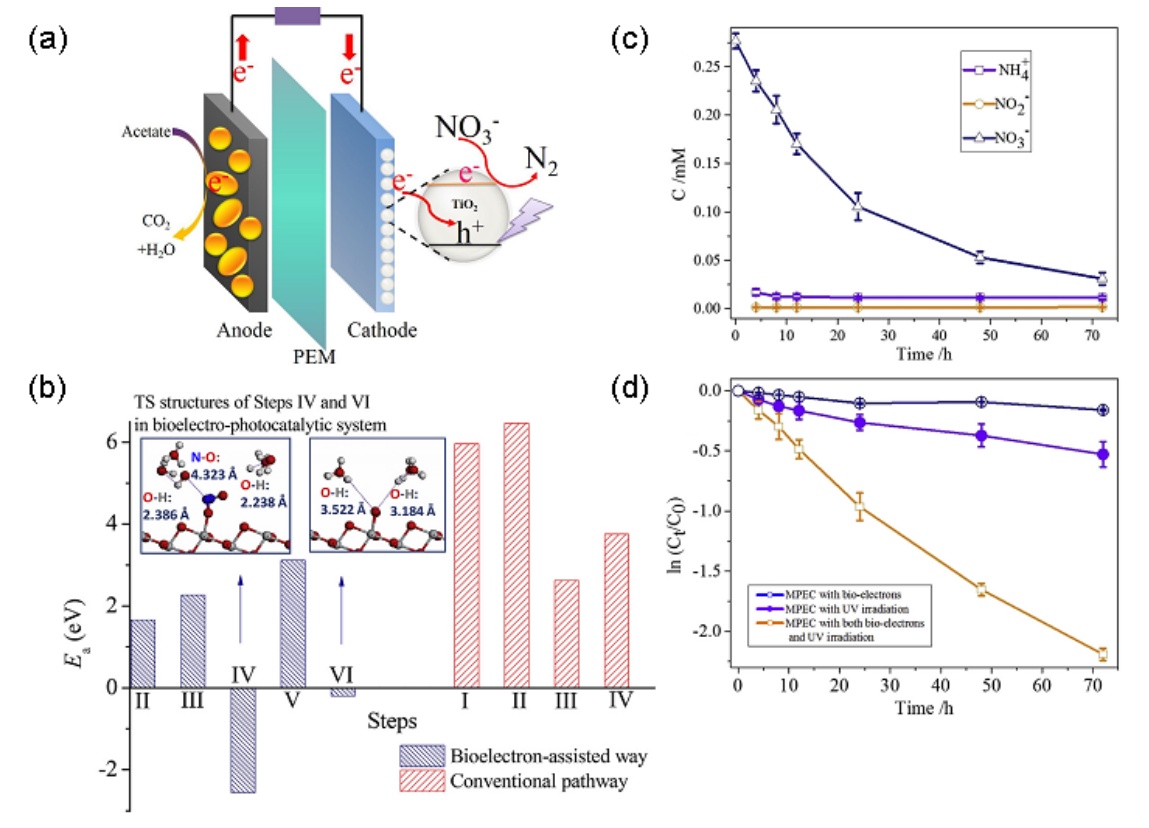
Figure 17. ( a ) Scheme of the bio electro-photocatalytic denitrification system. ( b ) Comparison of energy barrier (Ea) for photocatalytic denitrification in a bioelectronic-assisted way and the conven- tional pathway. The Ea of each step for NO 3– reduction on the TiO 2 (101) surface with the transition state (TS) structures of Steps IV and VI in the bio electro-photocatalytic system. Step I in the bio electro-photocatalytic system is the adsorption of NO 3– on the TiO 2 (101) surface. ( c , d ) Performance of the bio electro-photocatalytic denitrification system (c) the change of nitrate, nitrite, and ammo- nium concentrations in the denitrification process; ( d ) the relative concentration profiles of nitrate during the denitrification process in the bio electro- photocatalytic system (●: with bioanode to sup- ply the bio-electrons but without irradiation; ○ : with UV irradiation but without connecting to the bioanode; □ : with both UV irradiation and bio-electrons supply from the bioanode). Reproduced with permission from ref. [119]. Copyright 2017 Elsevier.